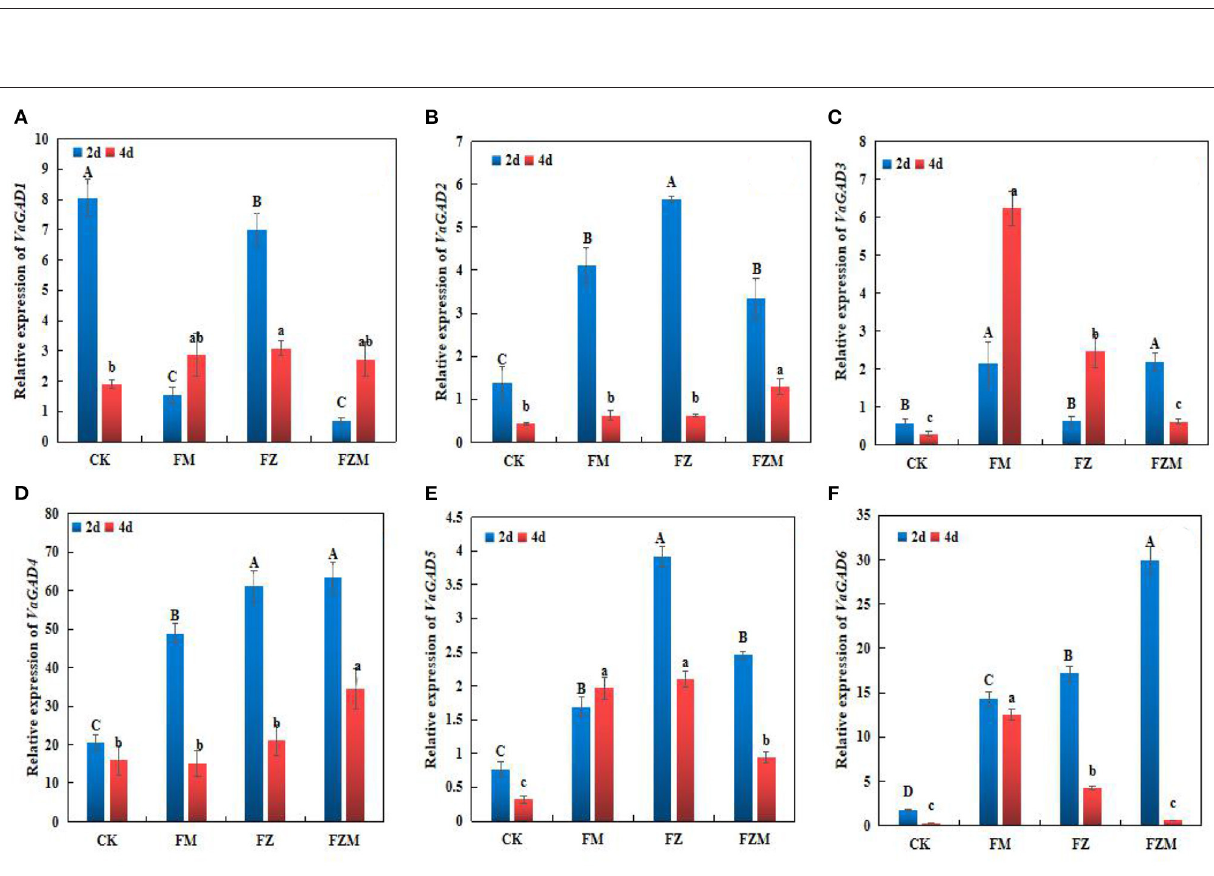
Frontiers in Nutrition |